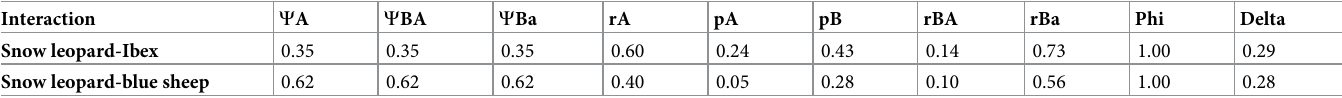
The predator-prey interaction is one of the key topics of behavioural ecology because preda- tion significantly influences prey population dynamics and behaviour and the ecosystem Table 2. Occupancy ( ψ ), detection probability (p and r), and species interaction factor (SIF—phi and Delta) estimated from co-occurrence occupancy models of predator prey interaction in Spiti Valley. Interaction C A C BA C